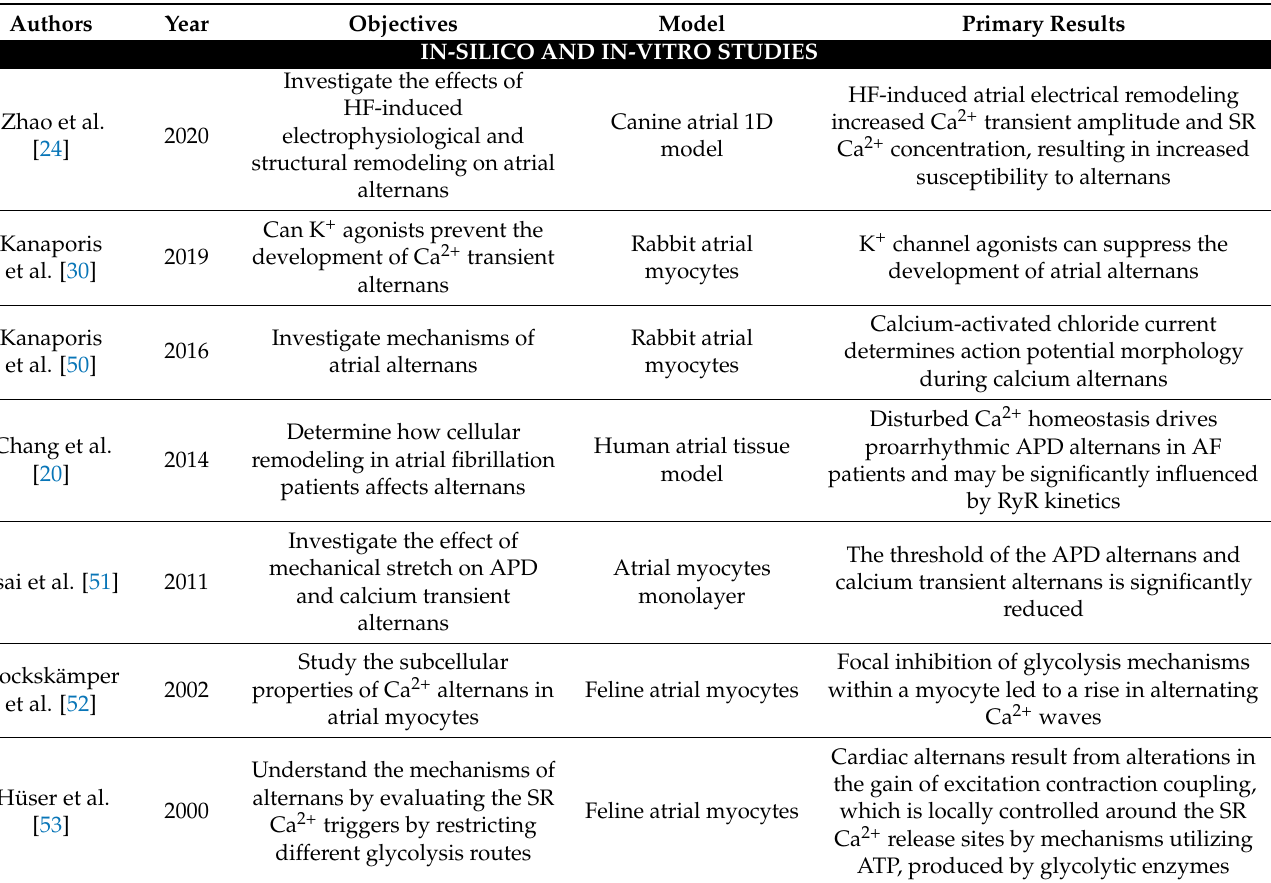
Objectives Model Primary